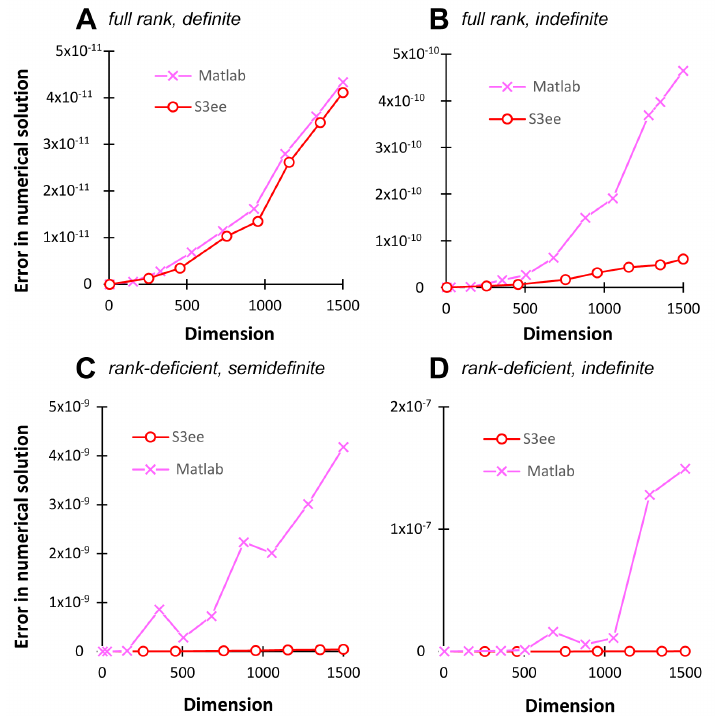
Figure 2. Comparative analysis of the S3ee implementation of the orthogonally scaled ABS algorithm and the Matlab mldivide function on randomly generated dense complex systems of linear